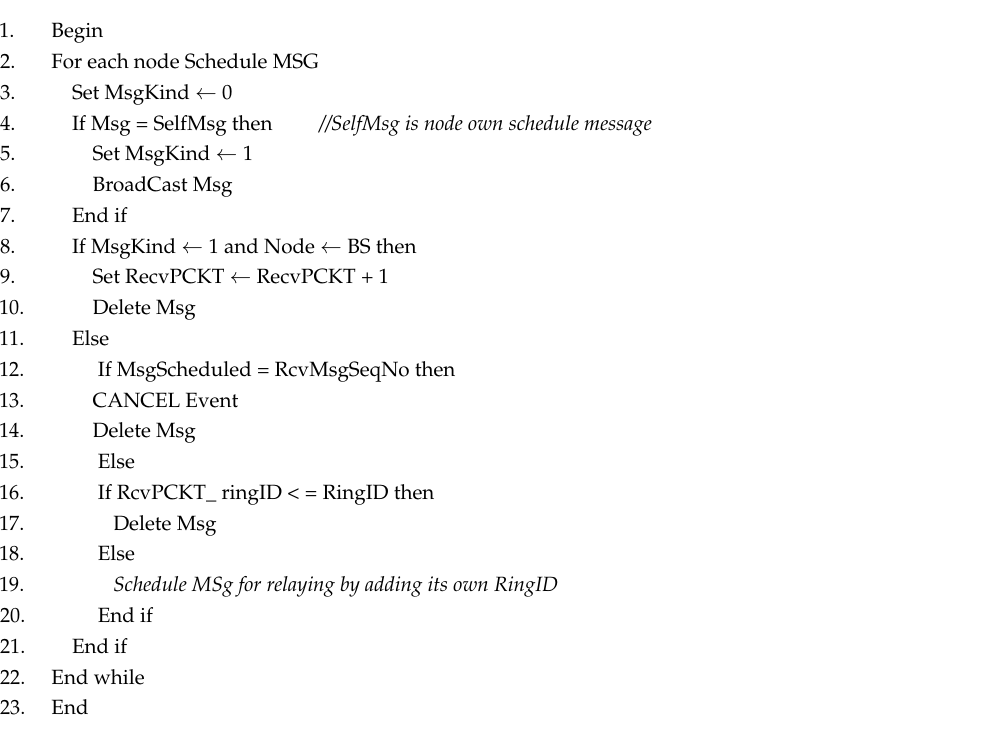
Algorithm 2: Pseudo code for Data Communication